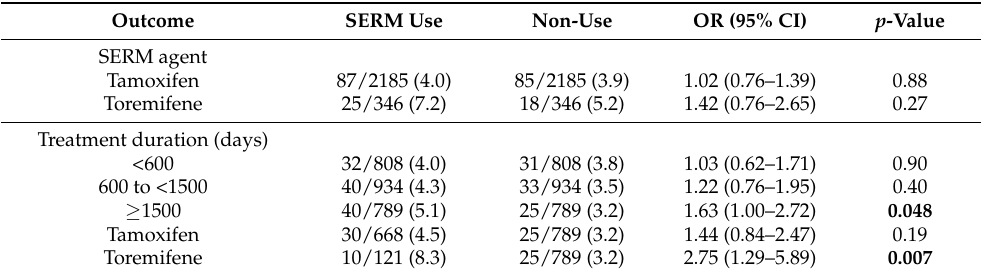
Table 3. PS-matched analysis of incident type 2 diabetes risk per treatment duration and SERM